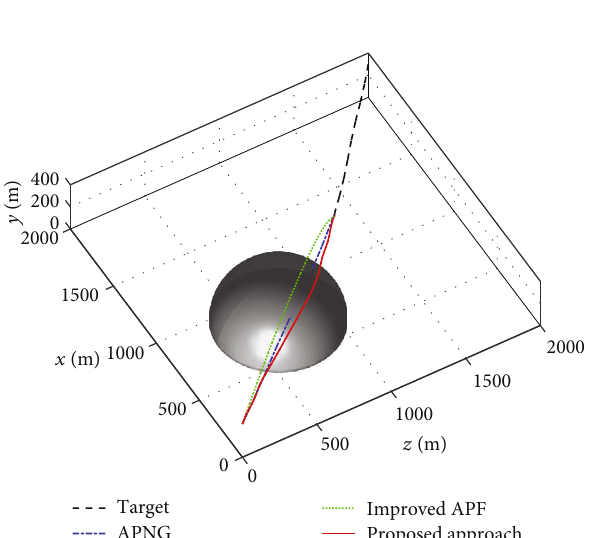
Figure 13: Changes of control inputs in case 2.